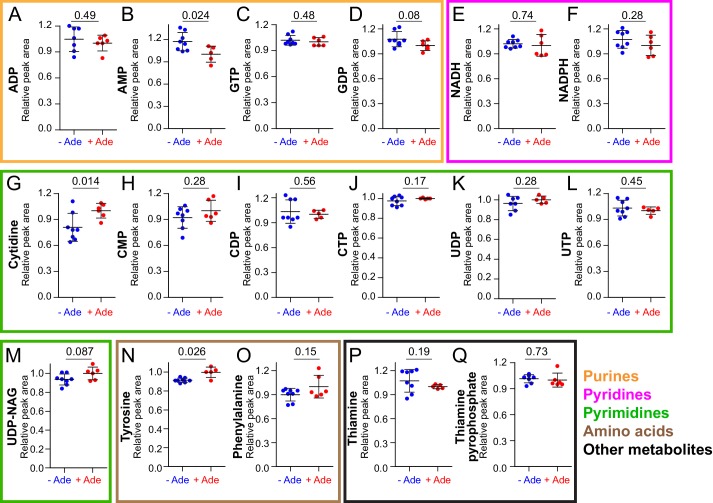
Quantification of metabolites not or poorly significantly affected by extracellular purine availability.Results were obtained on the prototrophic wild-type strain FY4 as in Figure 2. Quantifications were determined on independent metabolite extractions (N ≥ 5) and standard deviation is presented. For each metabolite, the amount measured in cells grown in the presence of adenine (red dots) was set at one and p-values indicated on the top of each panel were calculated from a Welch’s t-test.10.7554/eLife.43808.009Figure 2—figure supplement 3—source data 1.Non- or lowly-significant metabolic variations in the FY4 prototrophic strain ±adenine.